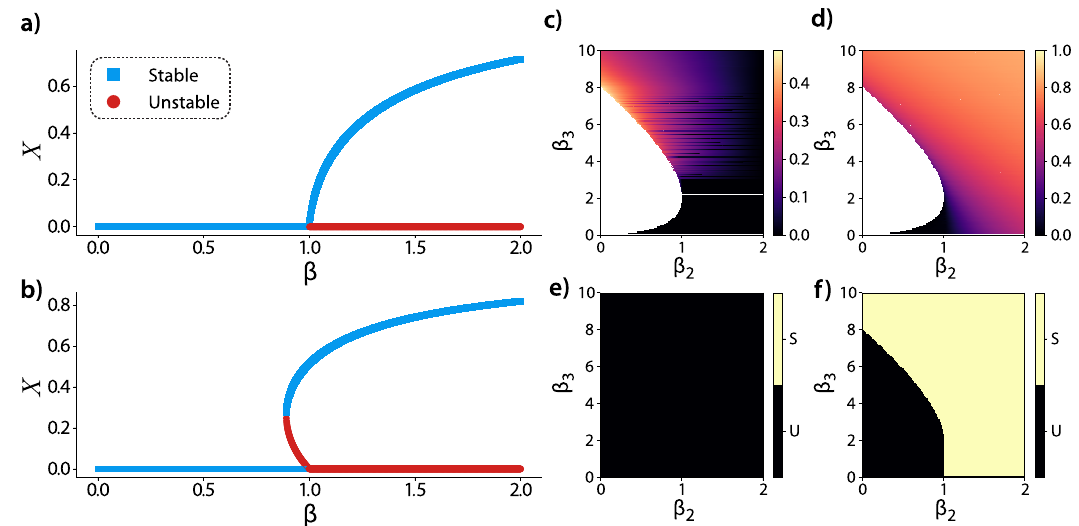
Fig. 3 Stability analysis of a social contagion dynamics on real-world, and synthetic hypergraphs. In a , the substrate is a high school contact pattern, while in b , a primary school contact pattern. The order parameter, X , is the fraction of active nodes, while β is the spreading rate. c – f Results for the stability analysis of a simplicial complex in the space of the spreading rates for pairwise interactions, β 2 , and triangles, β 3 . c , e Correspond, respectively, to the solution x (cid:2)(cid:3) (Eq. (37)) and its stability (Eq. (38)), whereas d , f represent the solution x (cid:2)þ 2 x (cid:2)(cid:3) are solutions of the mean- fi eld equation that describes the social contagion model. In e , f , U and S stand for unstable and stable, 2